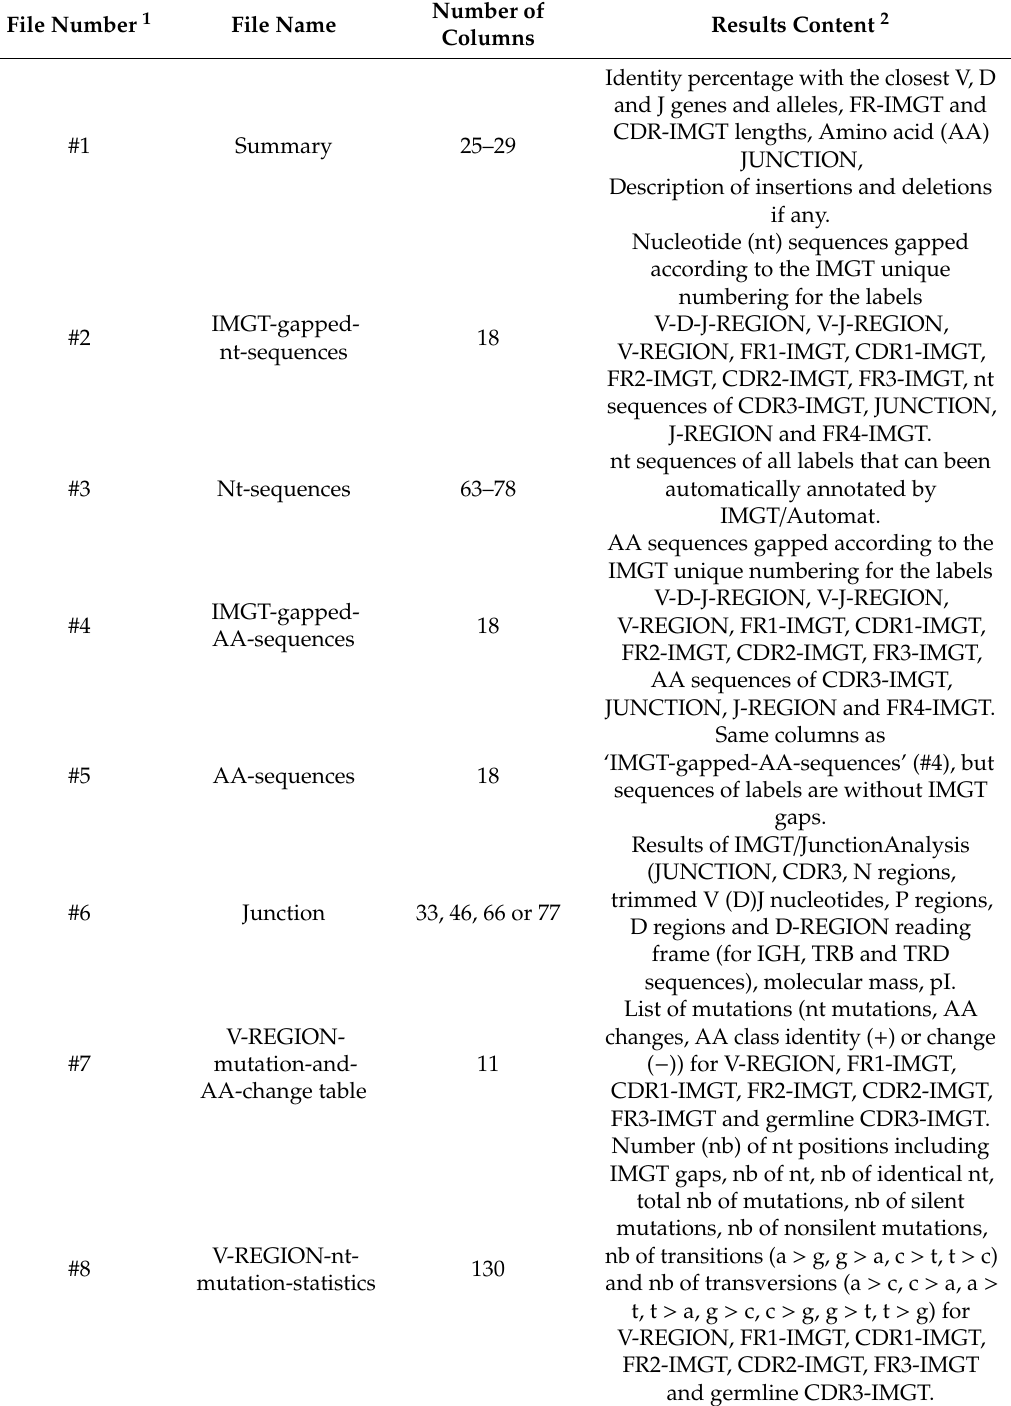
Table 13. Content of the eleven IMGT / HighV-QUEST results